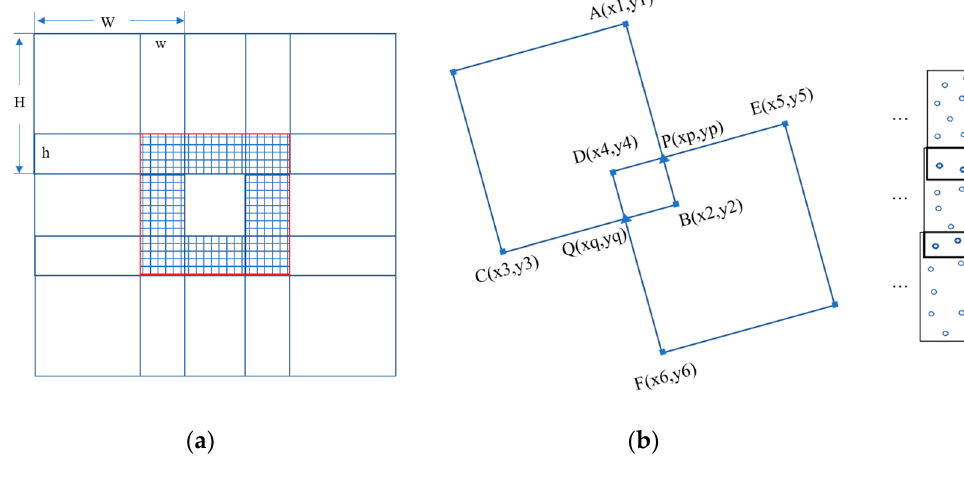
Figure 2. ( a ) Diagram of overlap ratio and overlap area. w and h are the width and height of the overlap region, respectively, and W and H are the width and height of the image, respectively. So, the overlap ratio is w / W or h / H . The shadow area is the overlap area in the block (red line) with the surrounding blocks, and the overlap area is 1 − (1 − 2 × w / W ) × (1 − 2 × h / H ). ( b ) Diagram of the coordinates acquirement of corner points in the overlap region. ( c ) Diagram of the adjustment model. The circles represent the deformation points. The thicker the circles, the more times the regions are overlapped. v represents the deformation rate of each point.